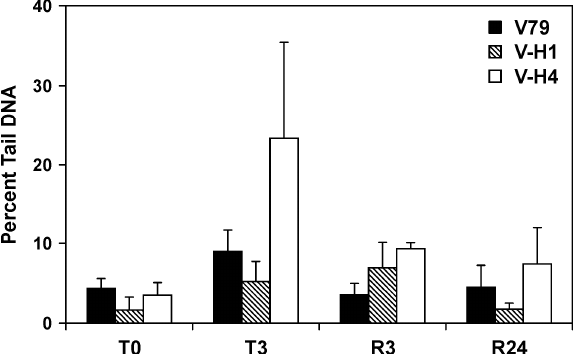
Figure 5. Formation and repair of DEB-induced DNA double strand breaks in V79, V-H1, and V-H4 cells. Single cell electrophoresis (comet assays) was performed on cells prior to and following exposure to 15 µM DEB as described in the Methods section. The data represent the percent of cellular DNA present in the “comet tail” plus the SEM, n = 3 or more. T0; pre-DEB exposure, T3; following